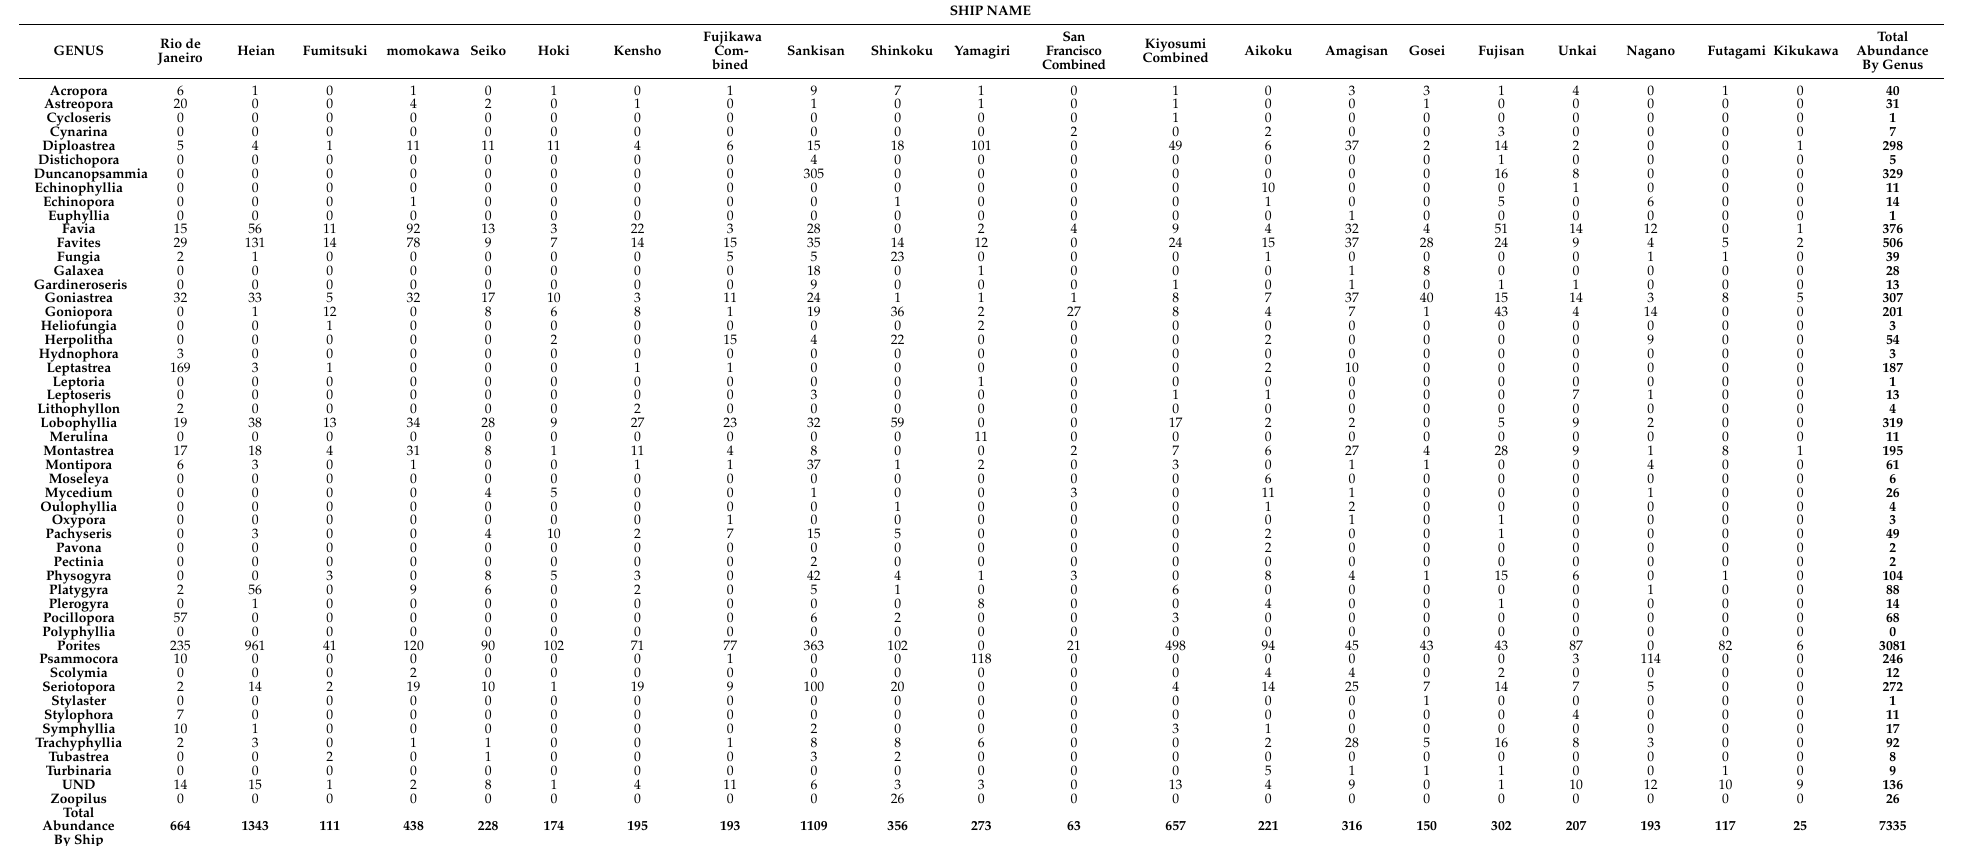
Table A2. Listing of coral genera found on 21 ships in the lagoon of Chuuk